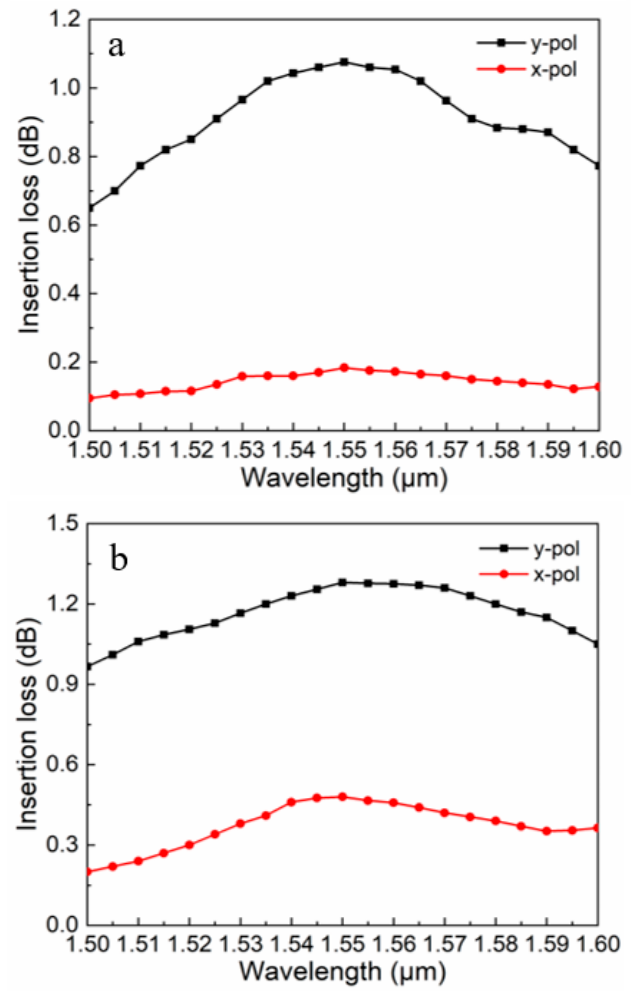
Figure 6. Various insertion loss (IL) values of the x- and y-pol lights for the proposed PCF-PBS ( a ) with the As 2 S 3 layer and ( b ) without the As 2 S 3 layer versus wavelength when Λ = 2.2 µ m, d 1 = 1.1 µ m, d 2 = 2.2 µ m, and t = 150 nm.